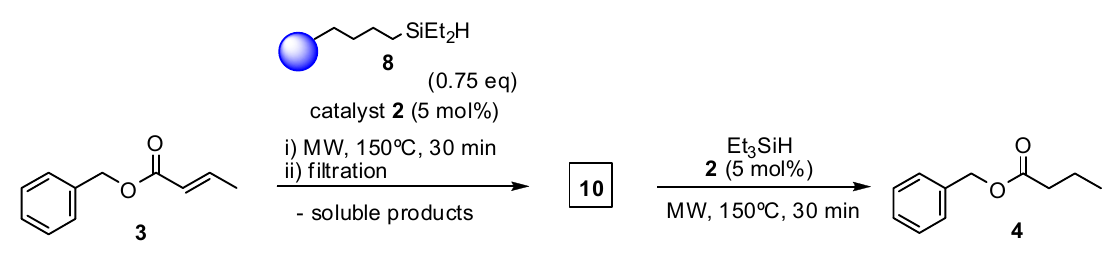
Figure 2. Crotonate 3 bound to the resin ( 10 ).